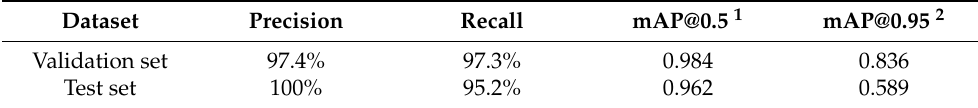
Figure 20. Variation in various indicators during the training. ( a ) Loss curves on training set, validation set and test set; ( b ) variation in precision and recall on validation set and test set; ( c ) variation of mAP on validation set and test set under the IoU thresholds of 0.5 and 0.95. Table 2. Performance statistics of the trained model on validation set and test